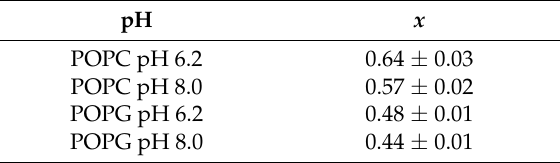
Table 2. The orientation distribution of bR in POPC and POPG vesicles under different pH values. (the value of x indicates the percentage of the TAMRA-bR with N-terminus pointing inside the